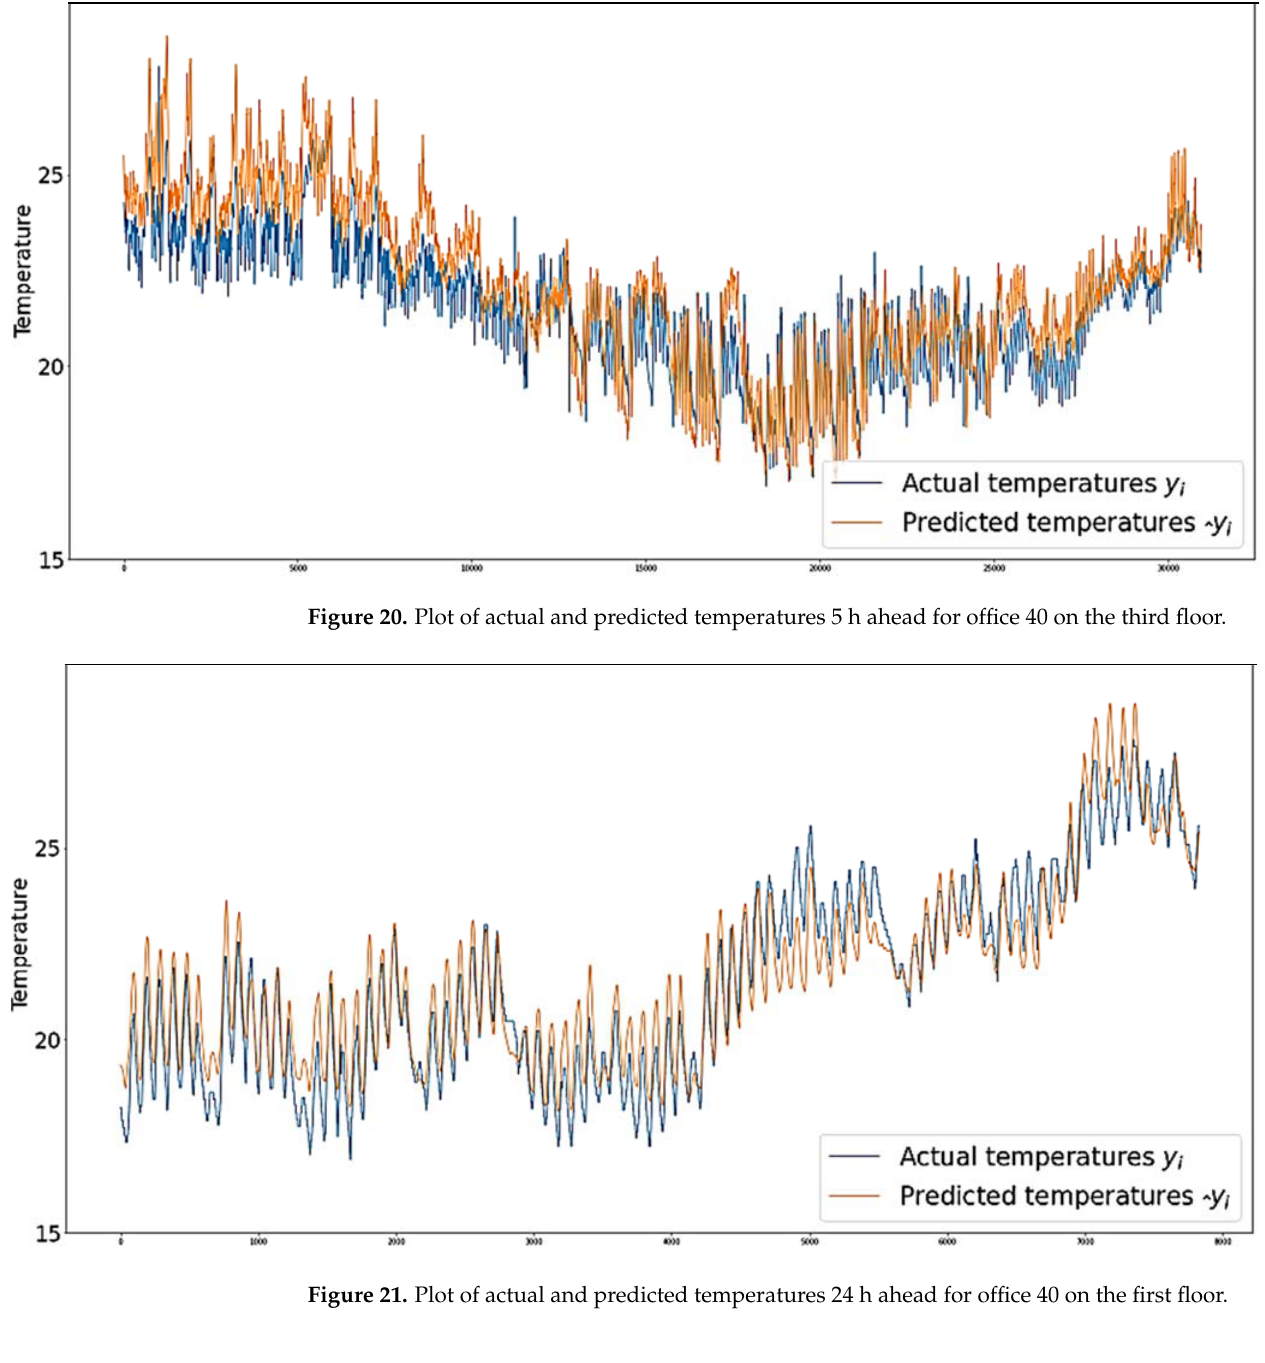
Figure 22. Plot of actual and predicted temperatures 24 h ahead for office 40 on the second floor.